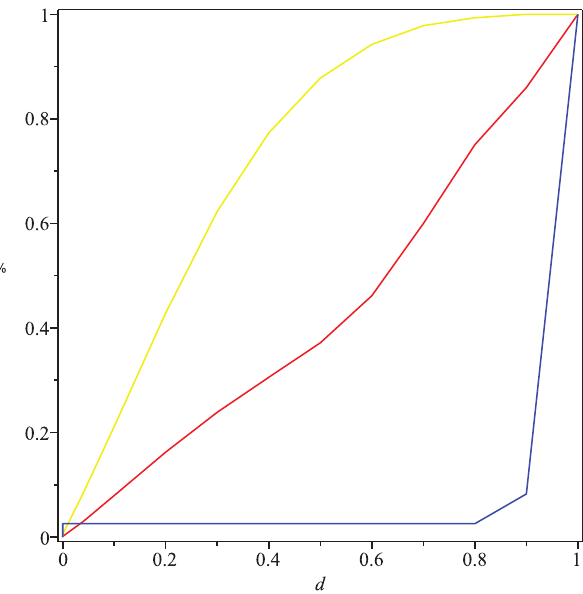
Figure 4. Distributions of the ranked values of the distance measure d E (red), d W (blue), d R (yellow). The X-axis denotes the values of the distance measure. The Y-axis denotes the number of graph pairs.